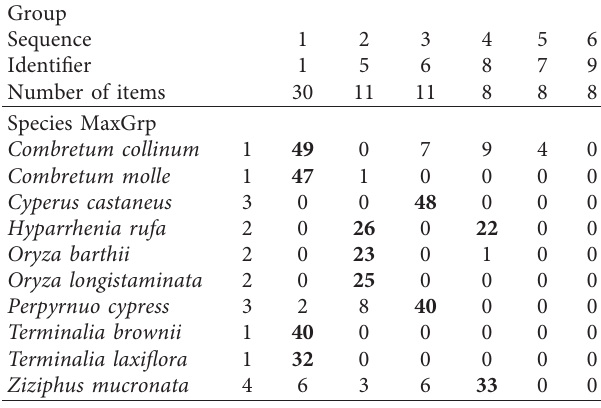
Figure 2: Dendrogram of cluster analysis results of species abundance data of the studied plant species of Gambella National Park. Plots forming the same cluster have similar symbols. Table 1: Chance within group agreement. Table 2: Indicator values (% of perfect indication based on combining values for relative abundance and relative